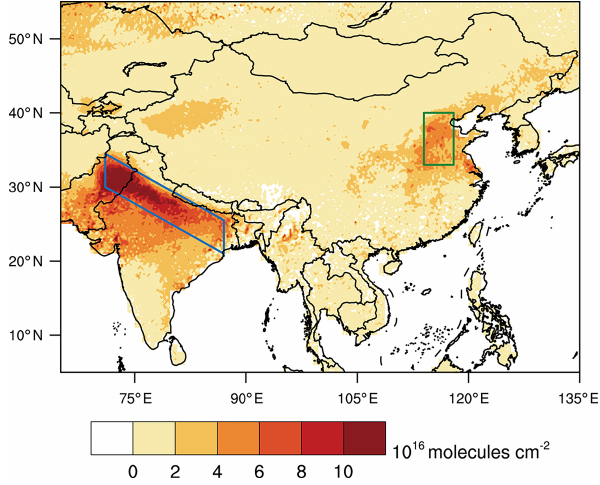
Figure 1. The spatial distribution of NH 3 total columns over East Asia from June to August 2010 retrieved from IASI measurements. The blue quadrangle represents the Indo-Gangetic Plain (IGP), and the green quadrangle represents the North China Plain